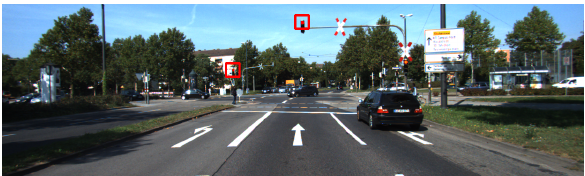
Figure 8: The detected traffic light lenses are correctly detected and their status are correctly recognized using stereo